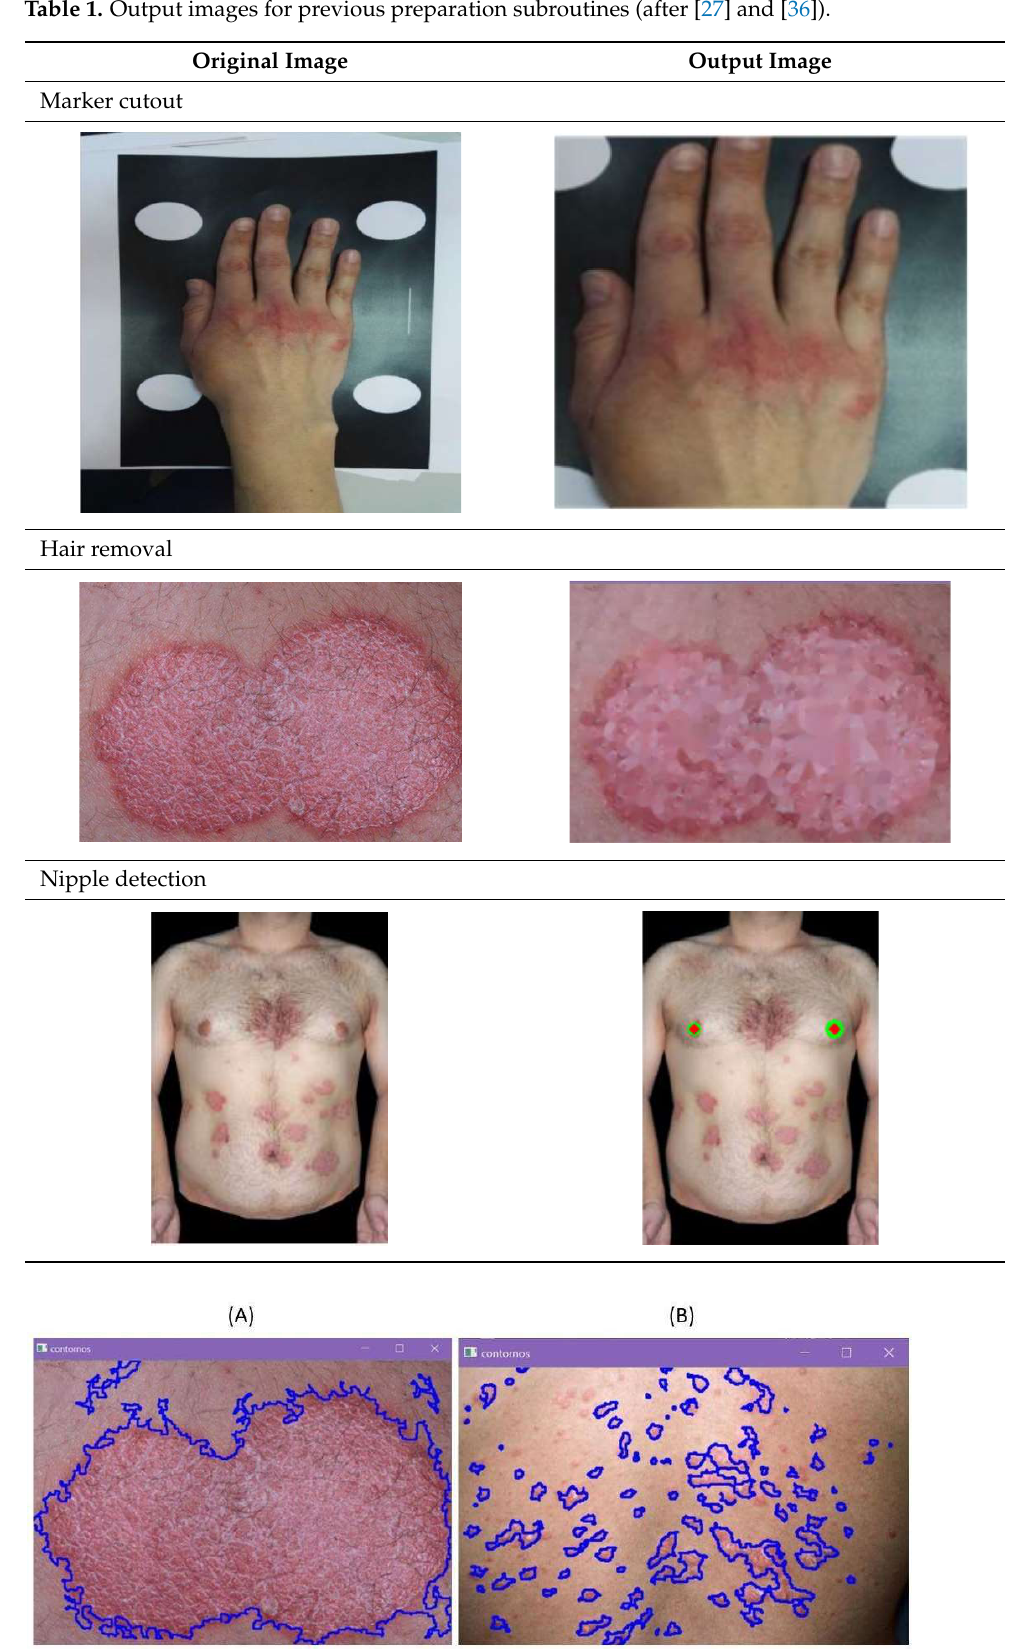
Figure 7. Classification example: ( A ) eruptive psoriasis and ( B ) plaque psoriasis.